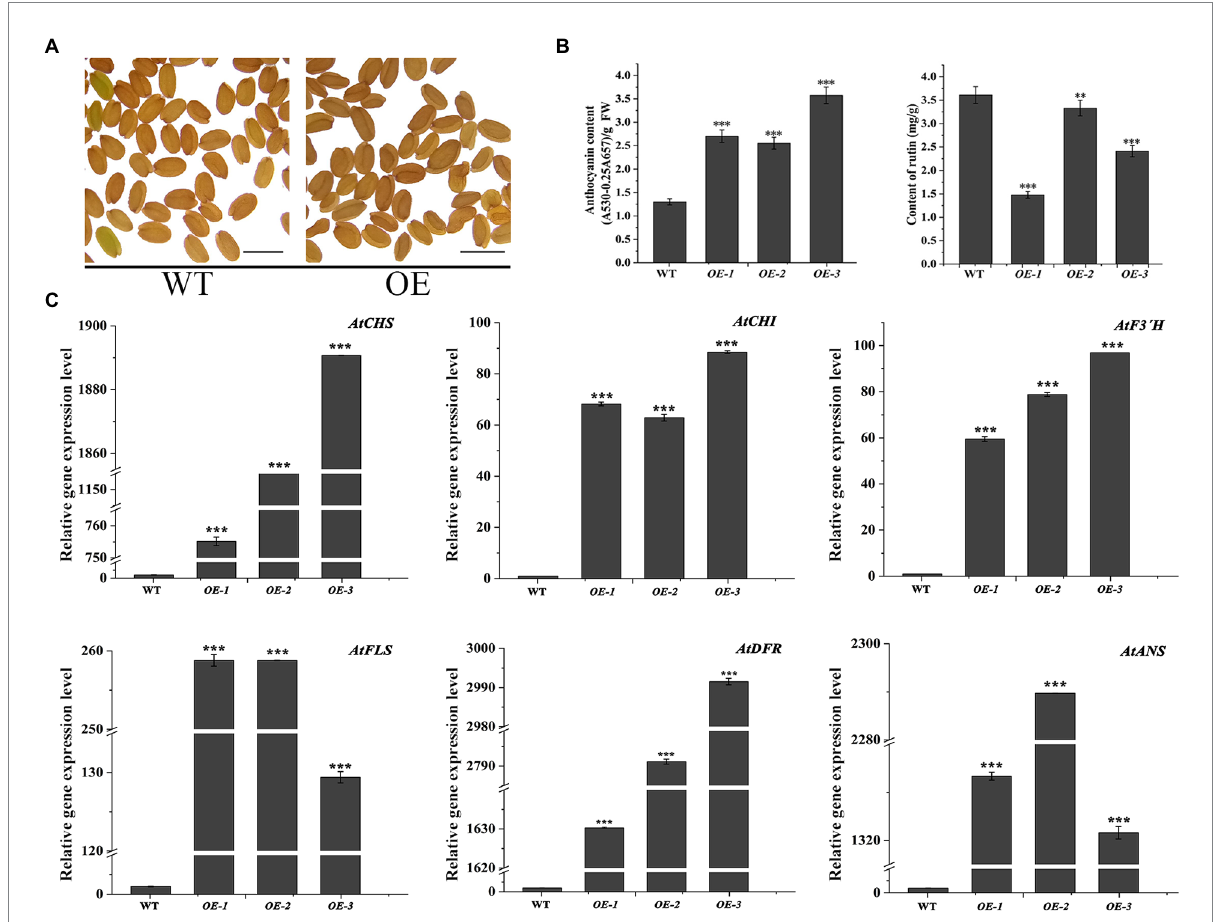
FIGURE 4 Overexpression of FtF3 ′ H1 gene in Arabidopsis thaliana . (A) Seed phenotypes of transgenic A. thaliana overexpressing FtH3 ′ H1 (OE) and WT (scale bar = 0.05 cm). (B) Determination of anthocyanin and rutin content in transgenic Arabidopsis lines OE-1, OE-2, and OE-3. WT is the control. Each value represents the mean of three replicates, and error bars indicate ± SD. ** p < 0.01 and *** p < 0.001. (C) qPCR analysis of the expression levels of anthocyanin biosynthesis genes in A. thaliana with the FtF3 ′ H1 overexpression. Atactin2 was used as the reference gene. Results represent mean values ± SD from three biological replicates. * p < 0.05, ** p < 0.01 and *** p < 0.001.